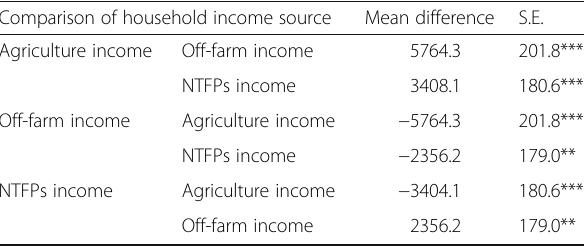
Table 3 Multiple comparisons of mean household incomes from agriculture, off-farm, and non-timber forest products Comparison of household income source Mean difference